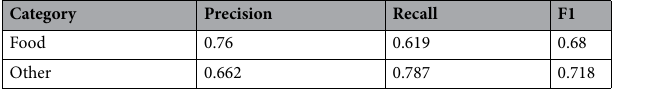
Table 3. Precision, recall and F1 scores for the automated classification component of our